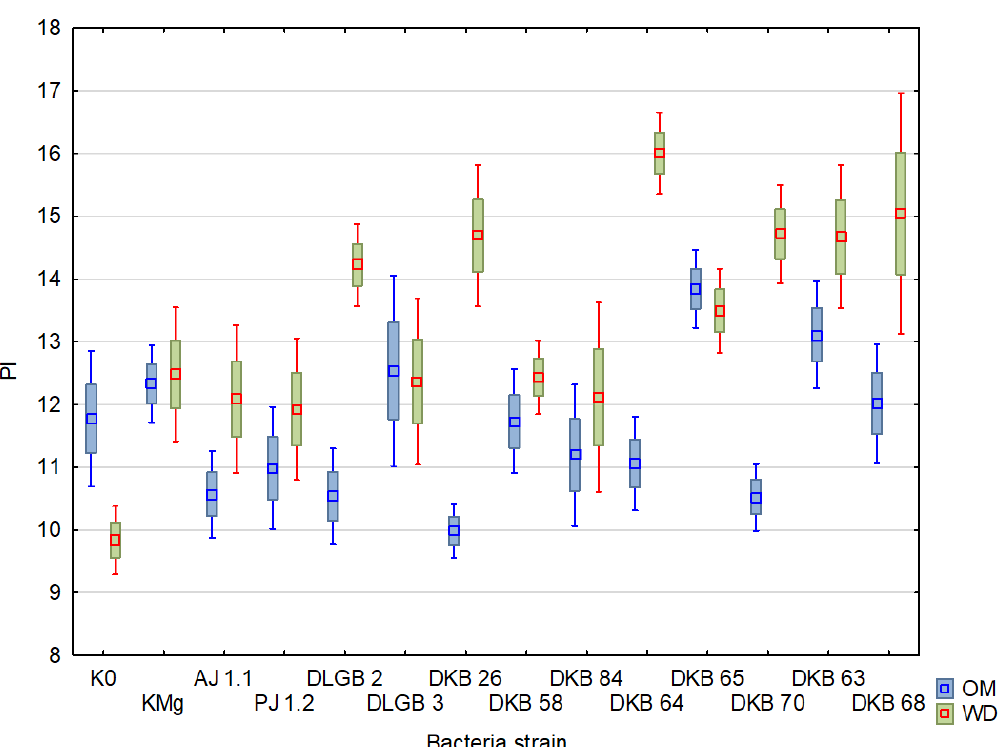
Figure 8. T FM in the leaves of strawberry plants inoculated with rhizosphere bacteria growing under different substrate moisture levels, where: where: OM — optimal moisture, WD — water deficit.